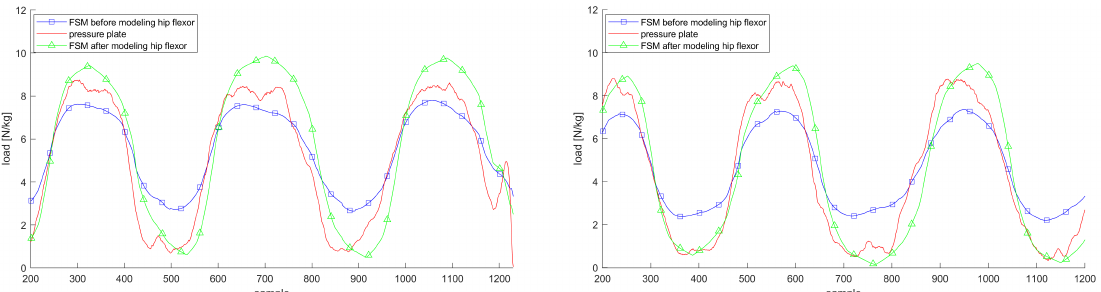
Figure 6. vGRF trajectories for the left and right foot before (blue squares) and after (green triangles) modeling the hip flexion compared to the pressure plate (red line) during AR movement; both plots show the estimations and measurements in Newton per